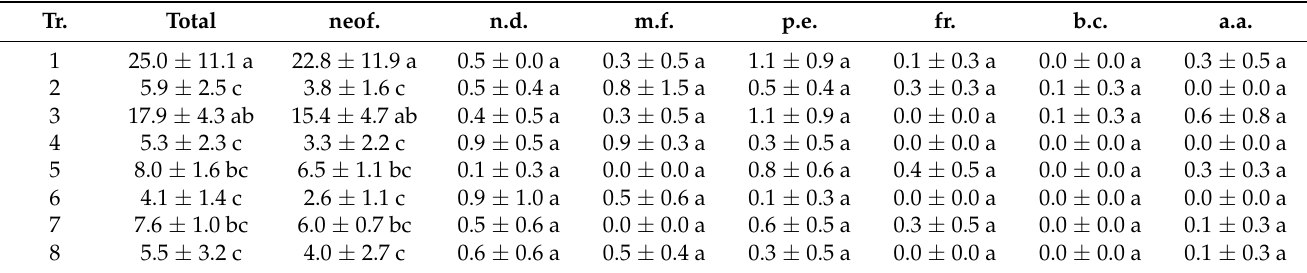
Table 3. Percentage of total rot incidences and of the responsible fungal pathogens in both evaluations with standard deviation of the mean. Means with identical letters do not differ significantly (Tukey Test α = 0.05). Abbreviations: Tr.: Treatments; neof.: neofabraea spp.; n.d.: Neonectria ditissima ; m.f